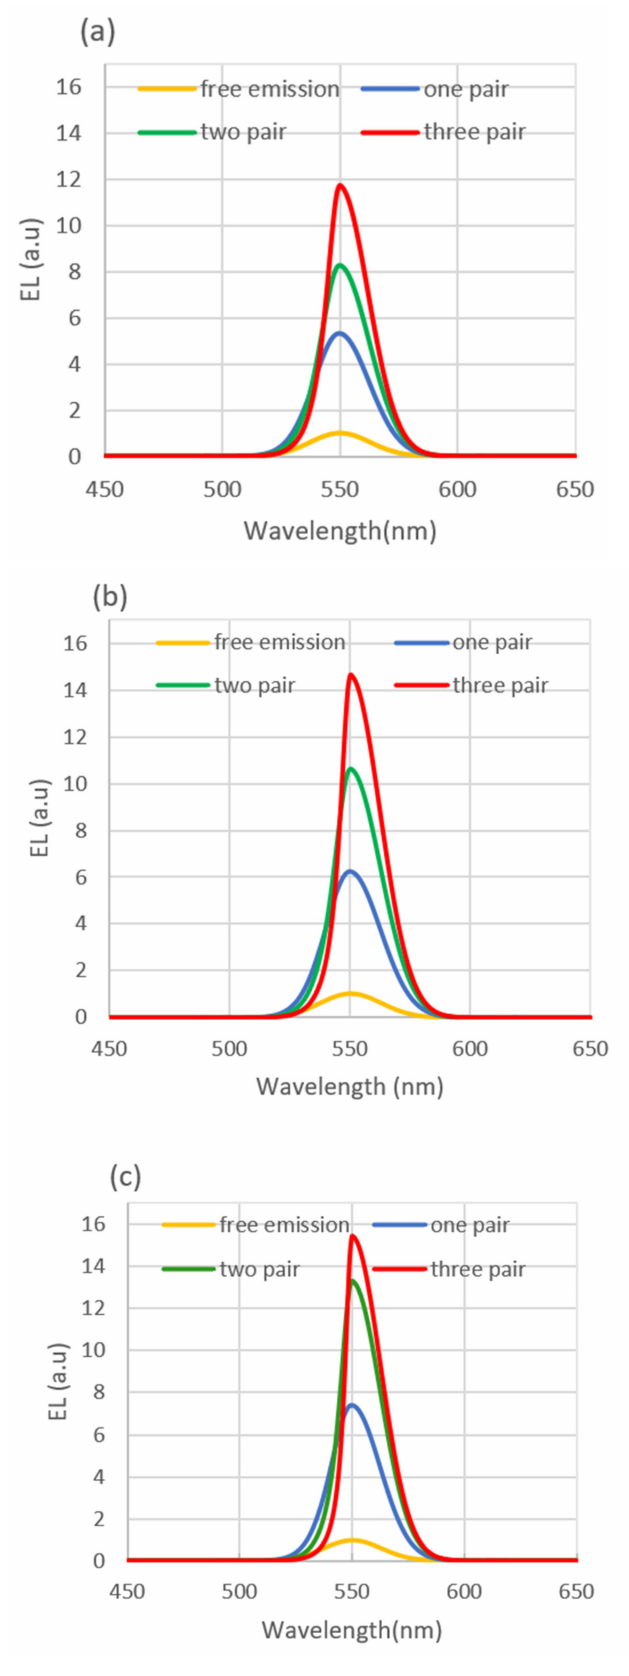
Figure 9. Electroluminance spectra for devices based on ( a ) DBR1 ( b ) DBR2 ( c )